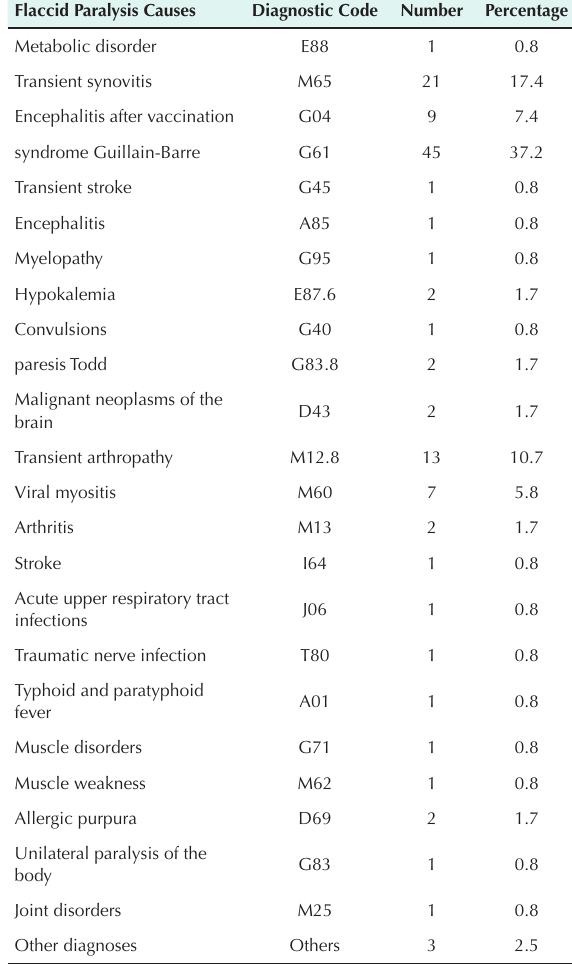
Table 1. Diagnostic Codes, Number, and Percentage of Causes of Flaccid Paralysis Flaccid Paralysis